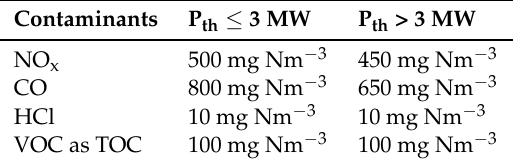
Table 2. Legal limits for biogas plants set in the Legislative Decree No. 118 of 19 May 2016